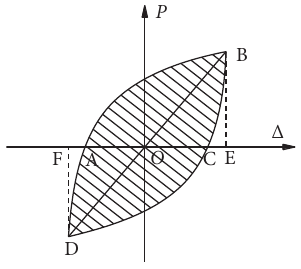
Figure 11: Energy dissipation capacity calculation diagram. Table 7: Equivalent viscous-damping coefficient.